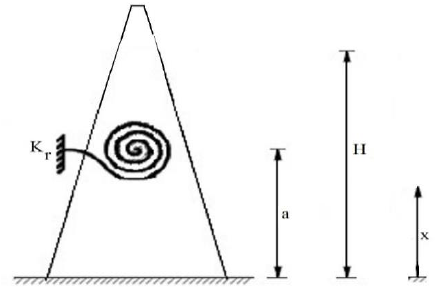
Fig. 1. A continuous model for the studied